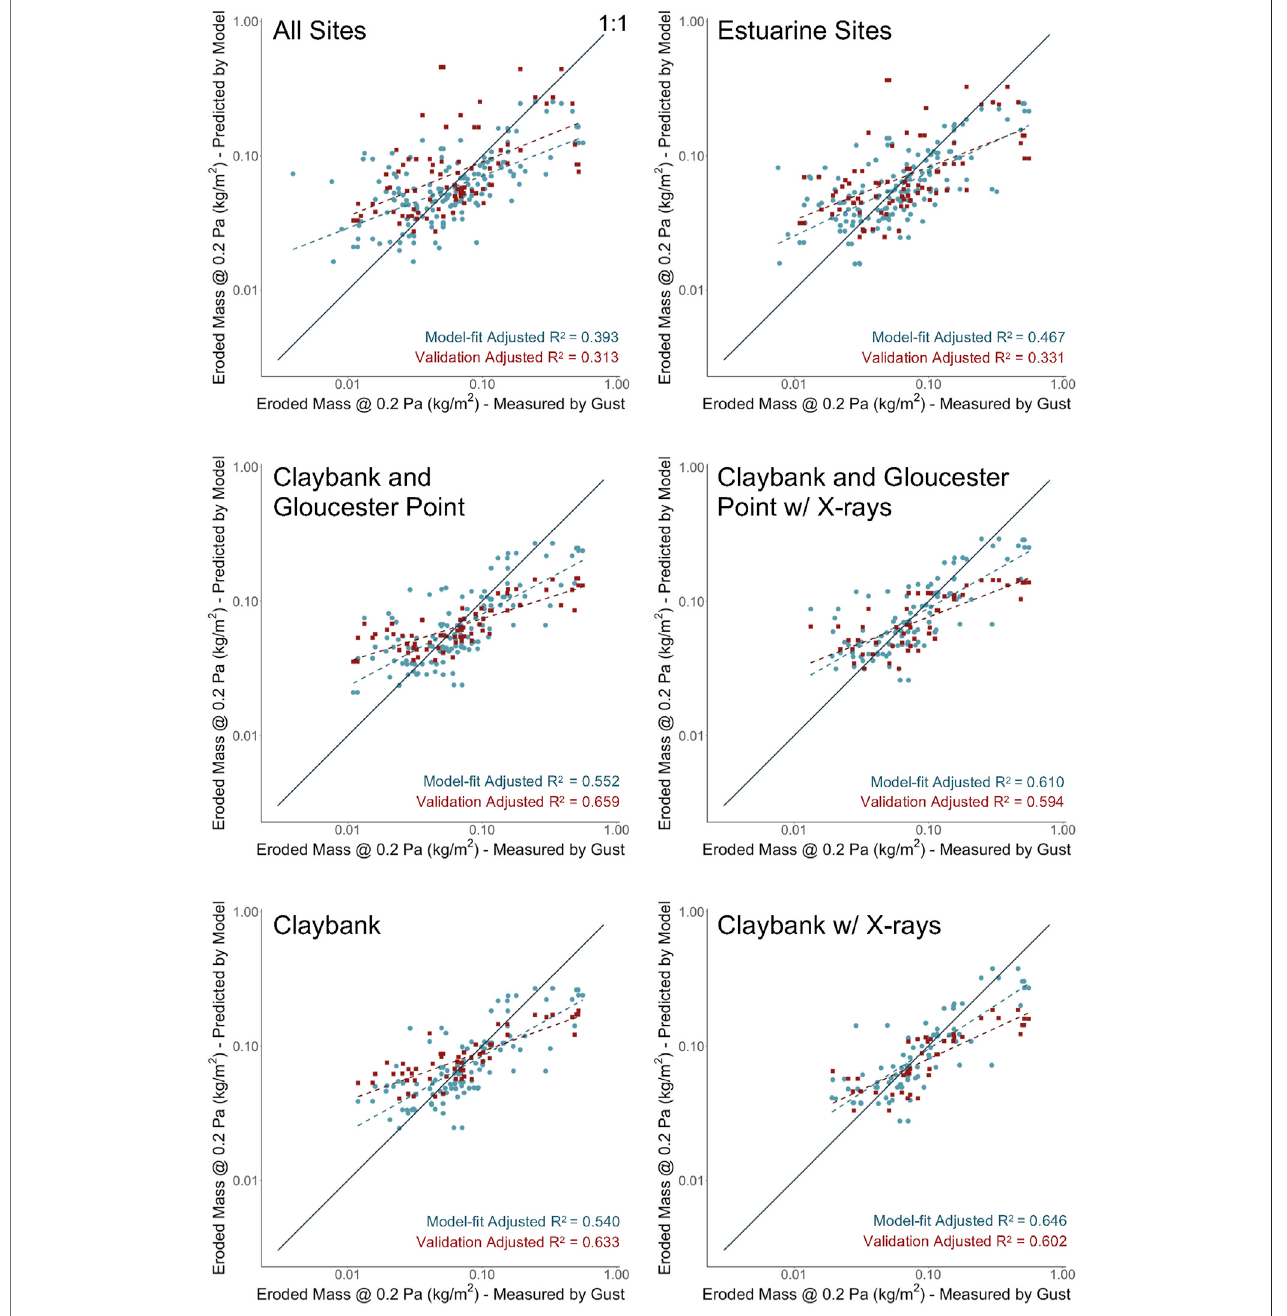
FIGURE A1 | Blue circles and blue dashed line show performance for models with Δ AICc = 0 from each data subset in the Eroded Mass Model Set relative to a black 1:1 line. Red squares and red dashed line show validation model performance when half of the data were chosen to reset the models ’ coef fi cients, and the same reset coef fi cients predicted erodibility using the other half of the data.